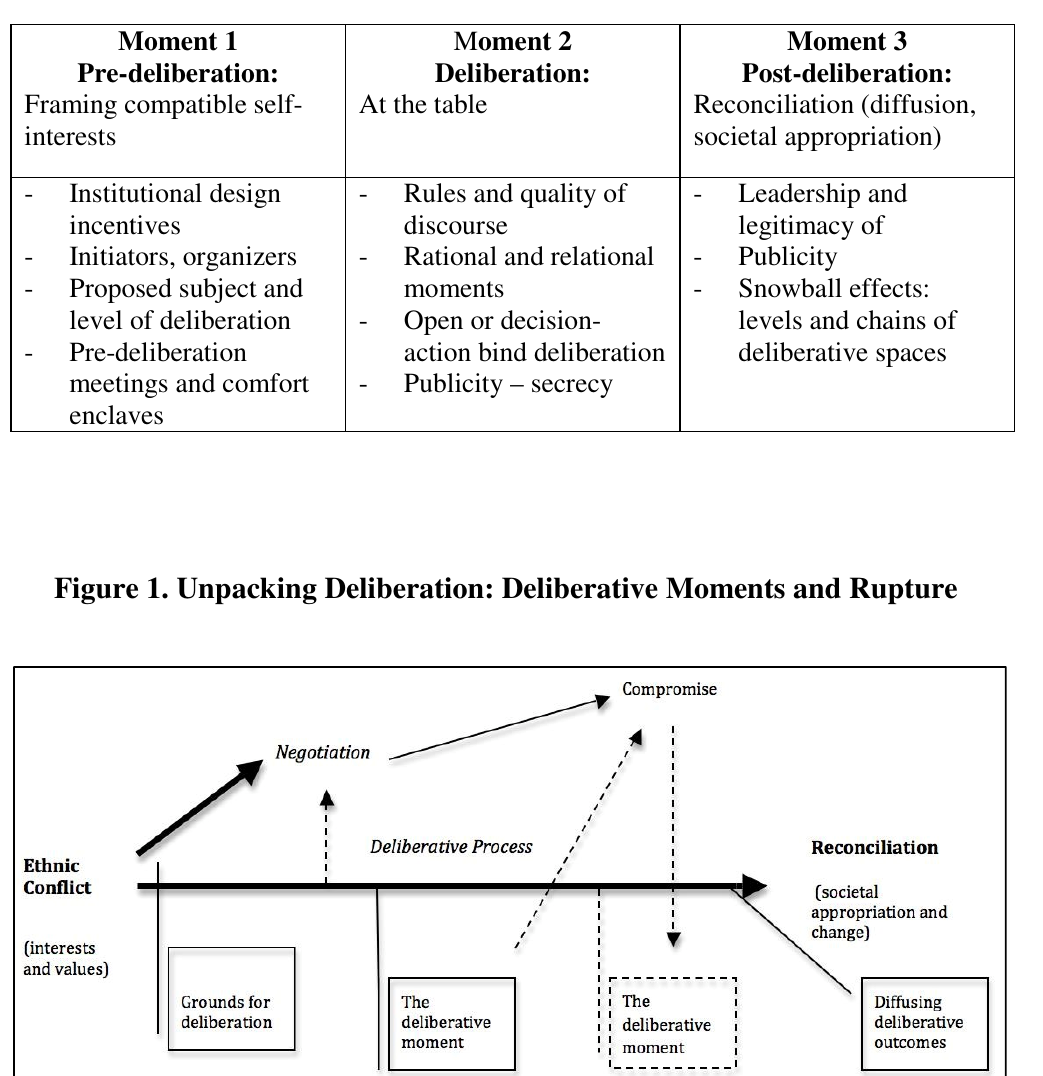
Table 1. The Three ‘Moments’ of Deliberation and their Components